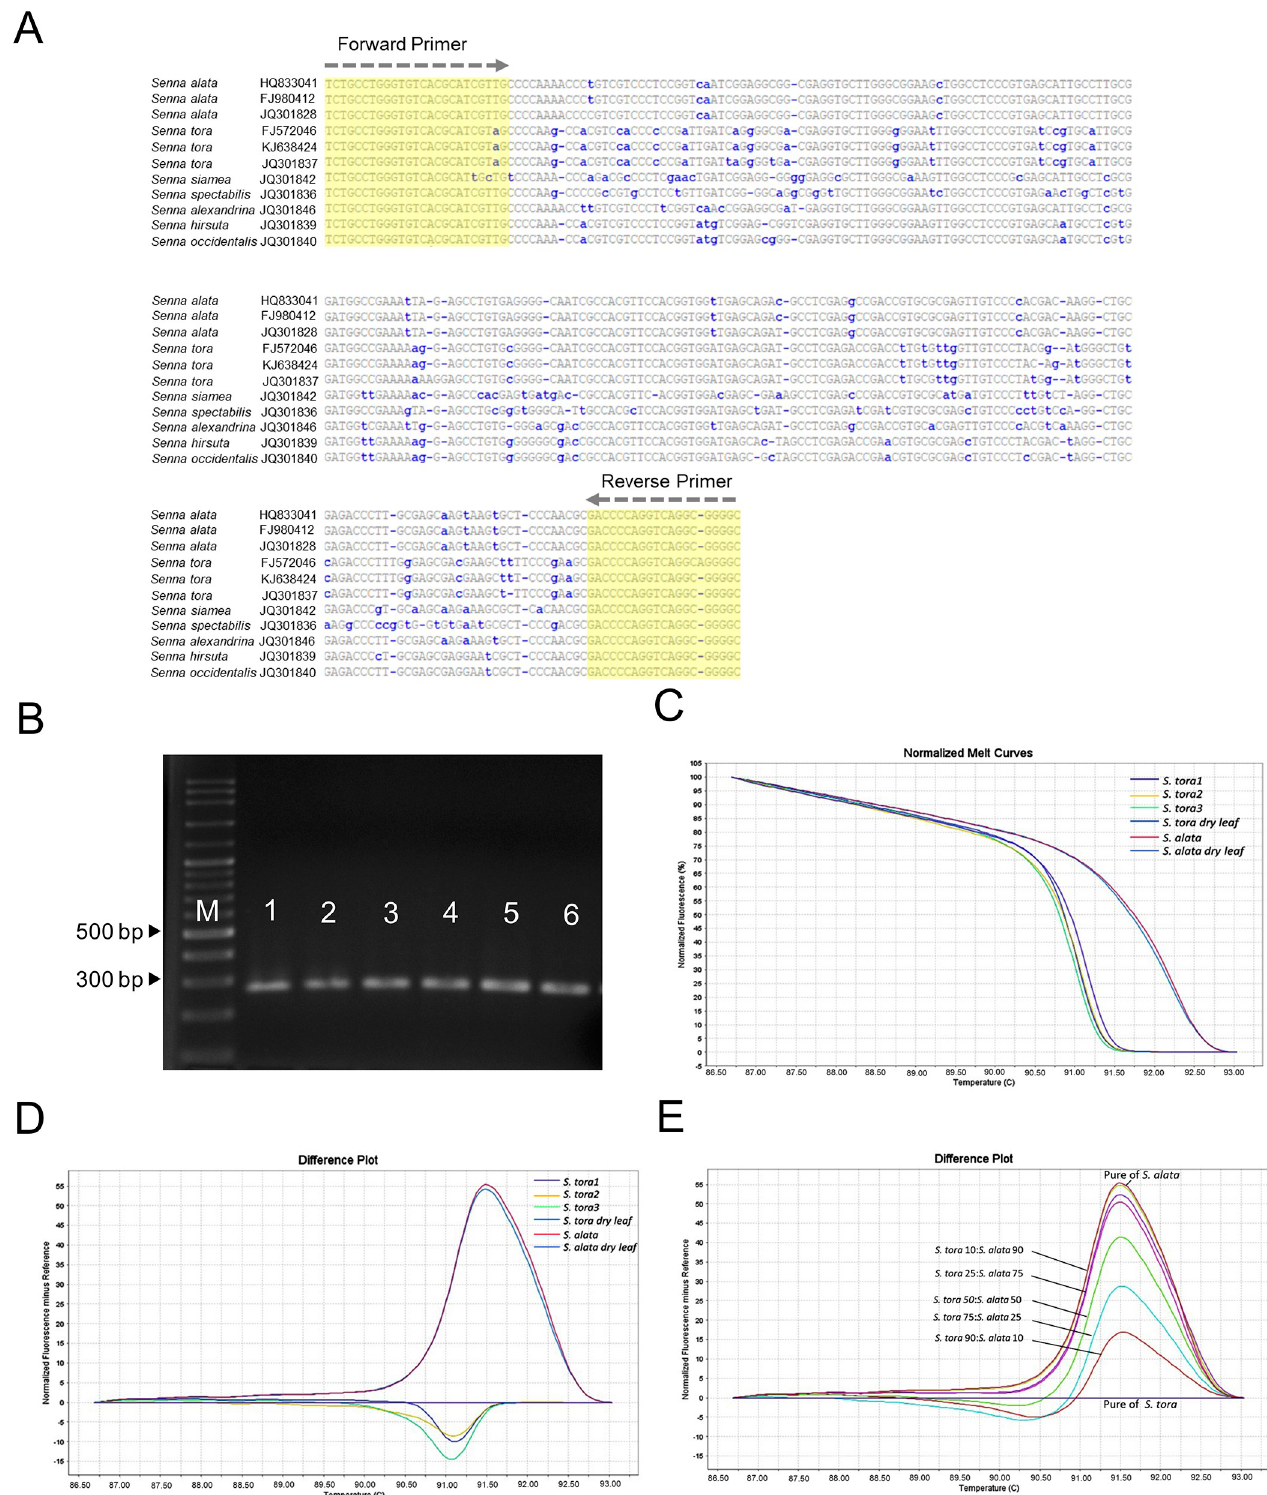
Fig 2. Distinction between S . tora and S . alata on the basis of DNA Bar-HRM using ITS2. (A) Multiple alignment of S . alata and S . tora . (B) Agarose gel electrophoresis of a 280 bp amplicon of an ITS2 locus amplified from S . alata and S . tora . Lanes 1–3: S . tora (fresh leaves); Lane 4: S . tora (dried leaves); Lane 5: S . alata (fresh leaves); Lane 6: S . alata (dried leaves). The DNA ladder size is indicated in base pairs. (C) The normalized melt curves profiles of S . tora and S .